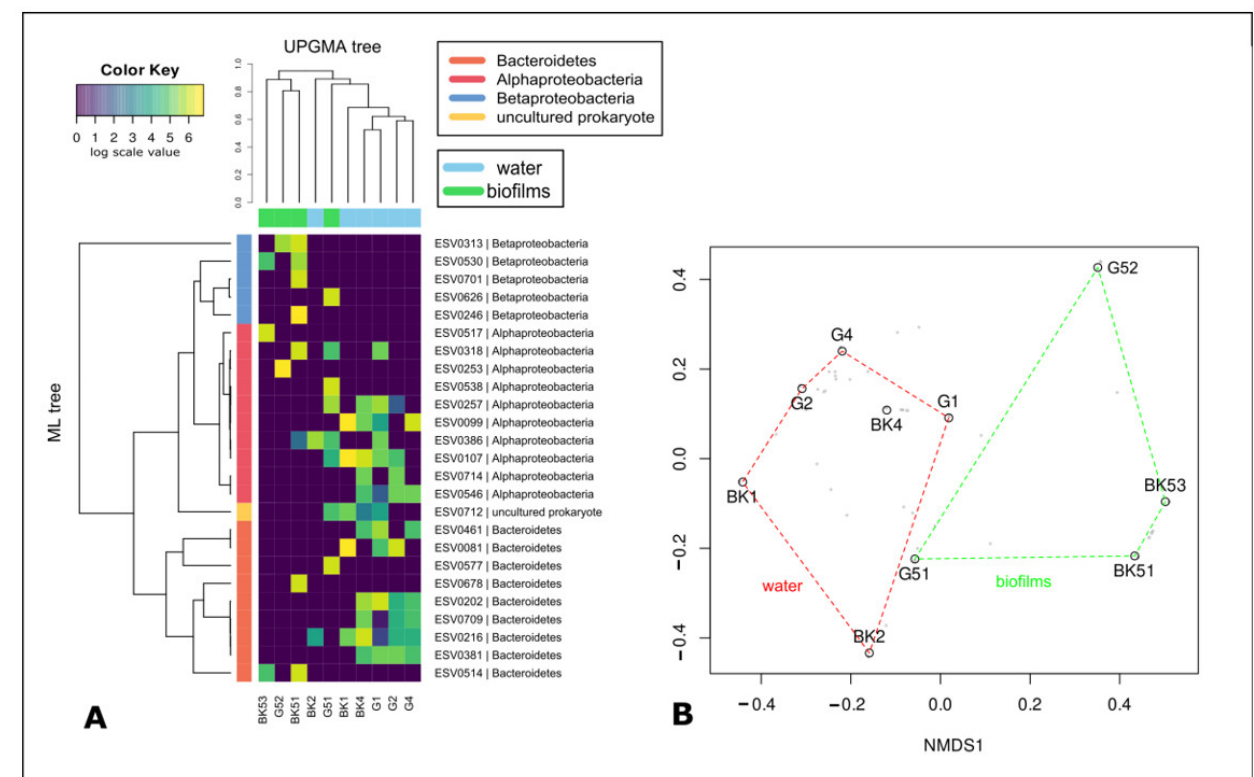
Figure 6. Similarities and differences between epilithon (G51, G52, BK51, BK53), neuston (BK1, G1), and plankton (BK2, BK4, G2, G4) of Lake Baikal. Heatmap of the 25 most represented ESVs of rhodopsin gene, UPGMA dendrogram and phylogenetic tree ( A ) and NMDS plot ( B ) based on the Bray-Curtis similarity matrix. Red lines highlight water cluster of samples; green lines highlight epilithic biofilms cluster of samples. BK—samples taken off the Bol’shiye Koty settlement; G—samples taken off the Bol’shoye Goloustnoye settlement.